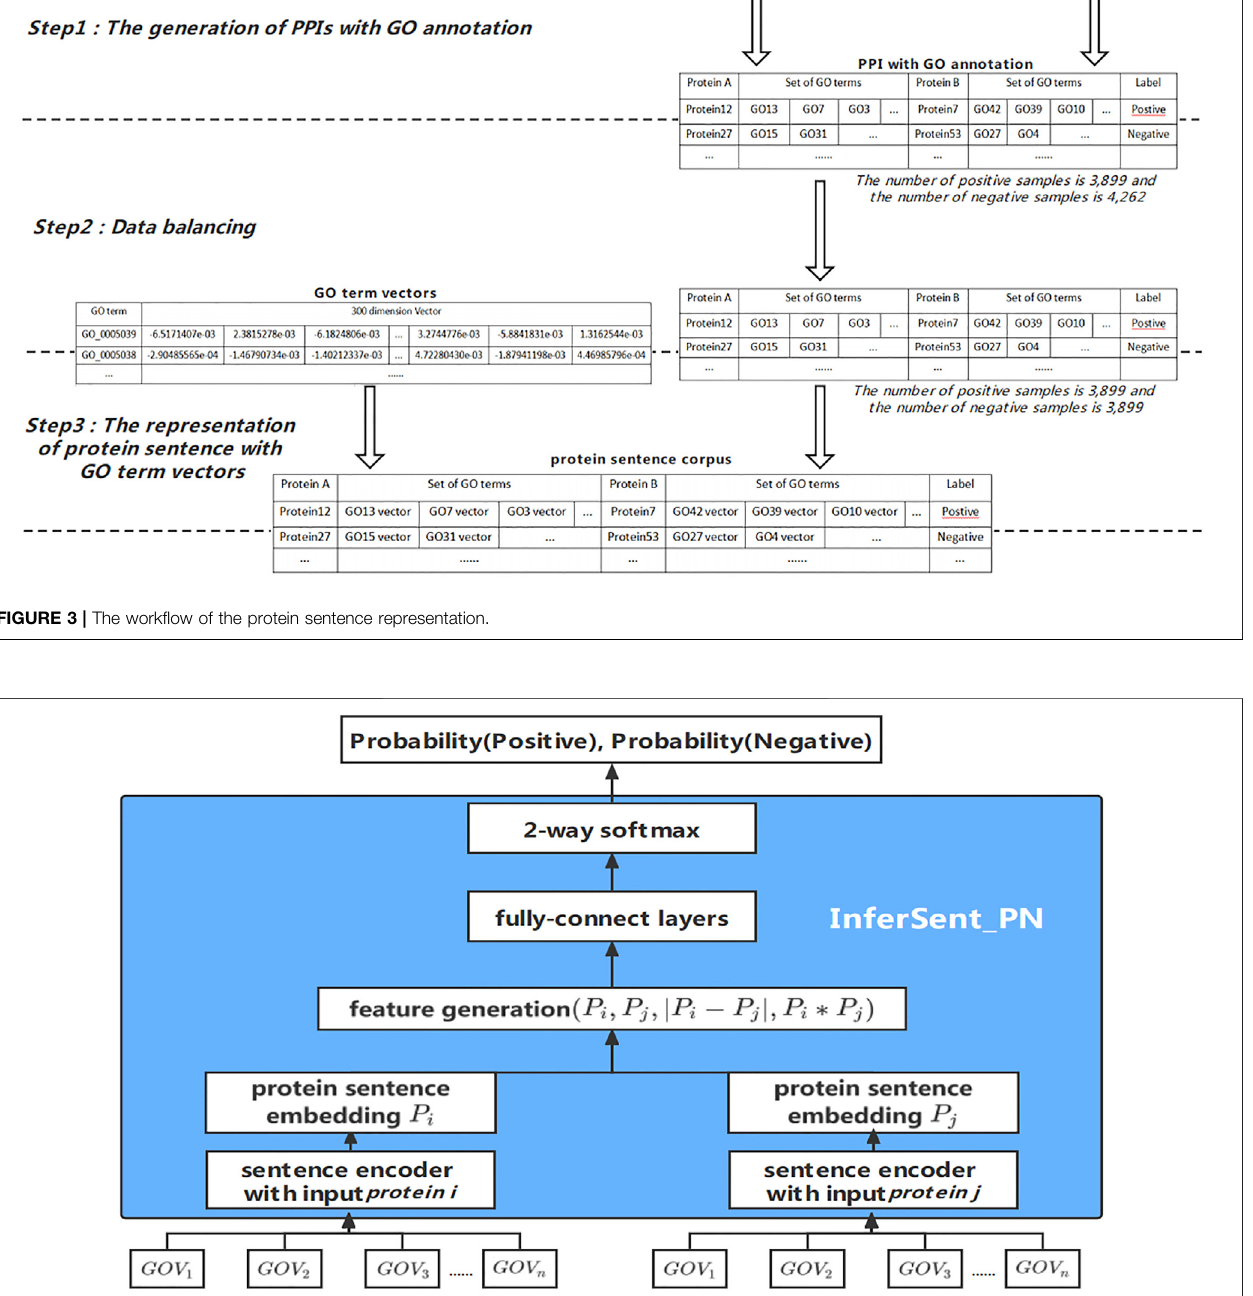
Frontiers in Genetics |